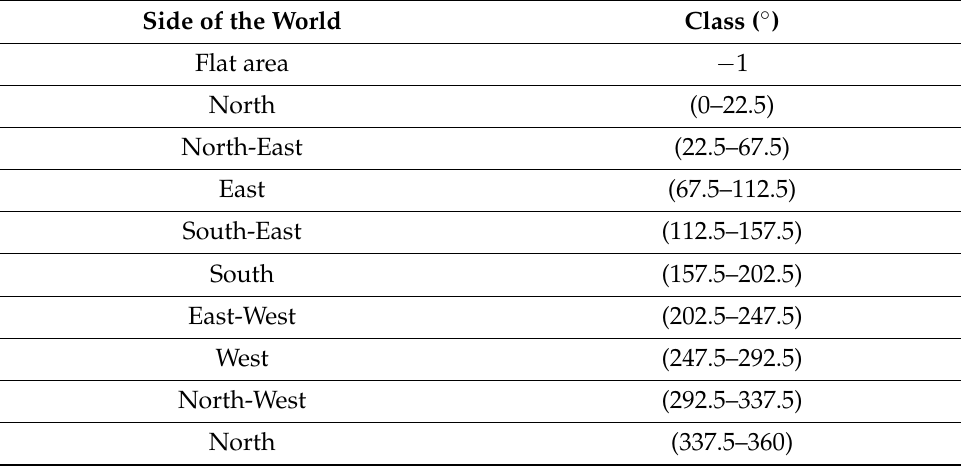
Table 1. Ranges of slope orientation values towards the sides of the world [33].